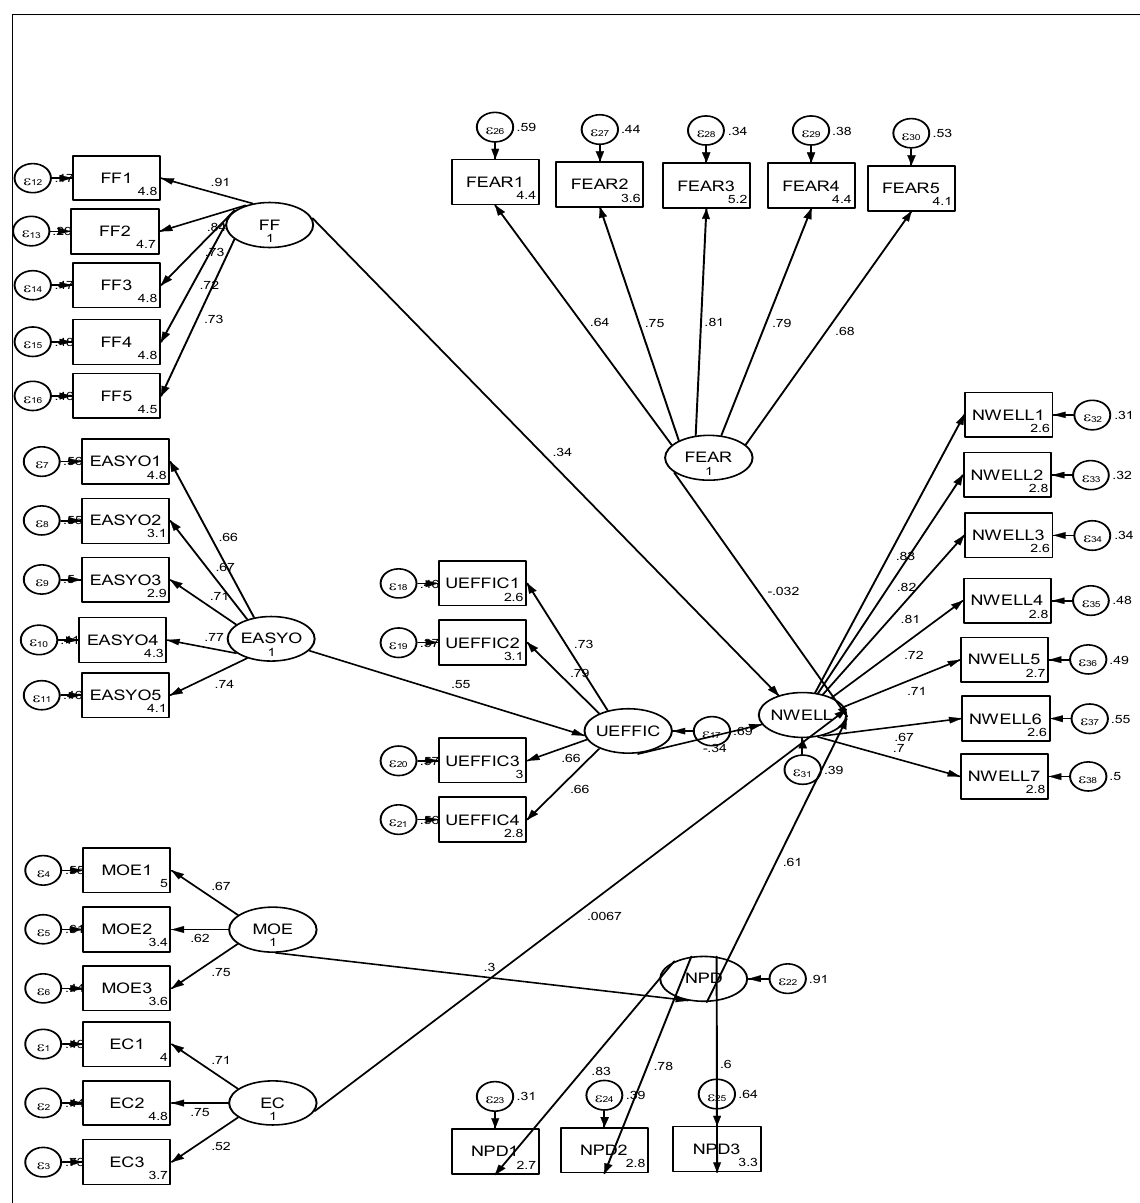
Figure 3. Results of the structural model.